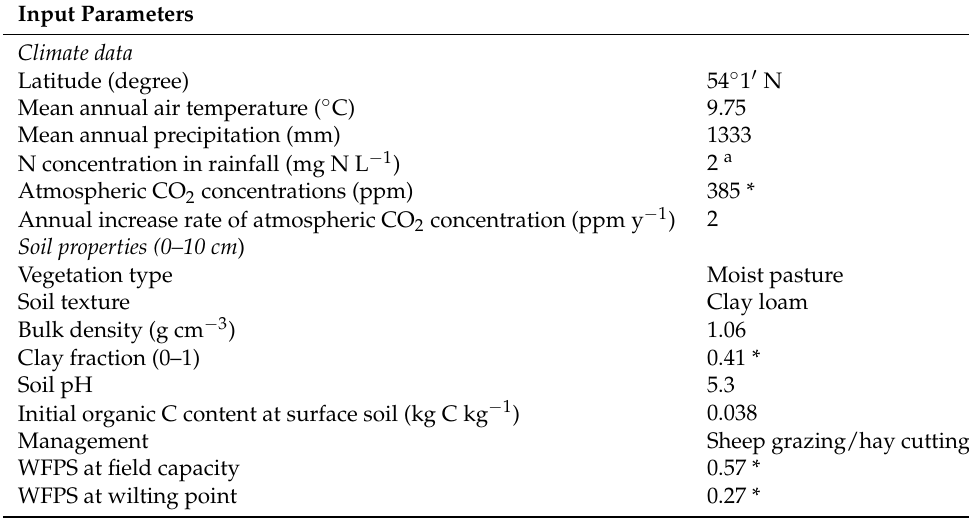
Table 1. DNDC model input